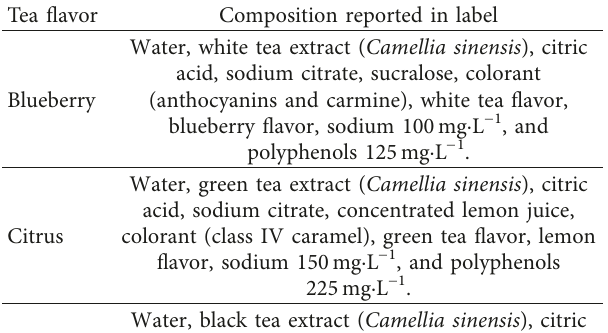
Table 1: Composition of ready-to-drink flavored-colored com- mercial teas. Tea flavor Composition reported in